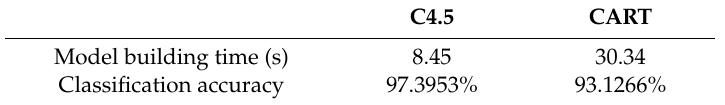
Table 7. The performance between the C4.5 and classification and regression tree (CART) algorithms.